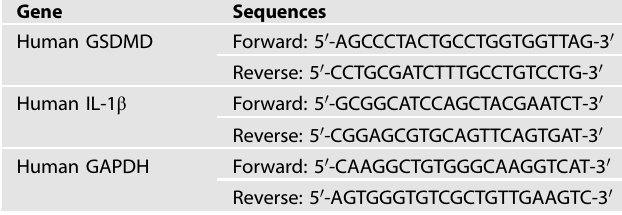
Table 1. The sequences of PCR